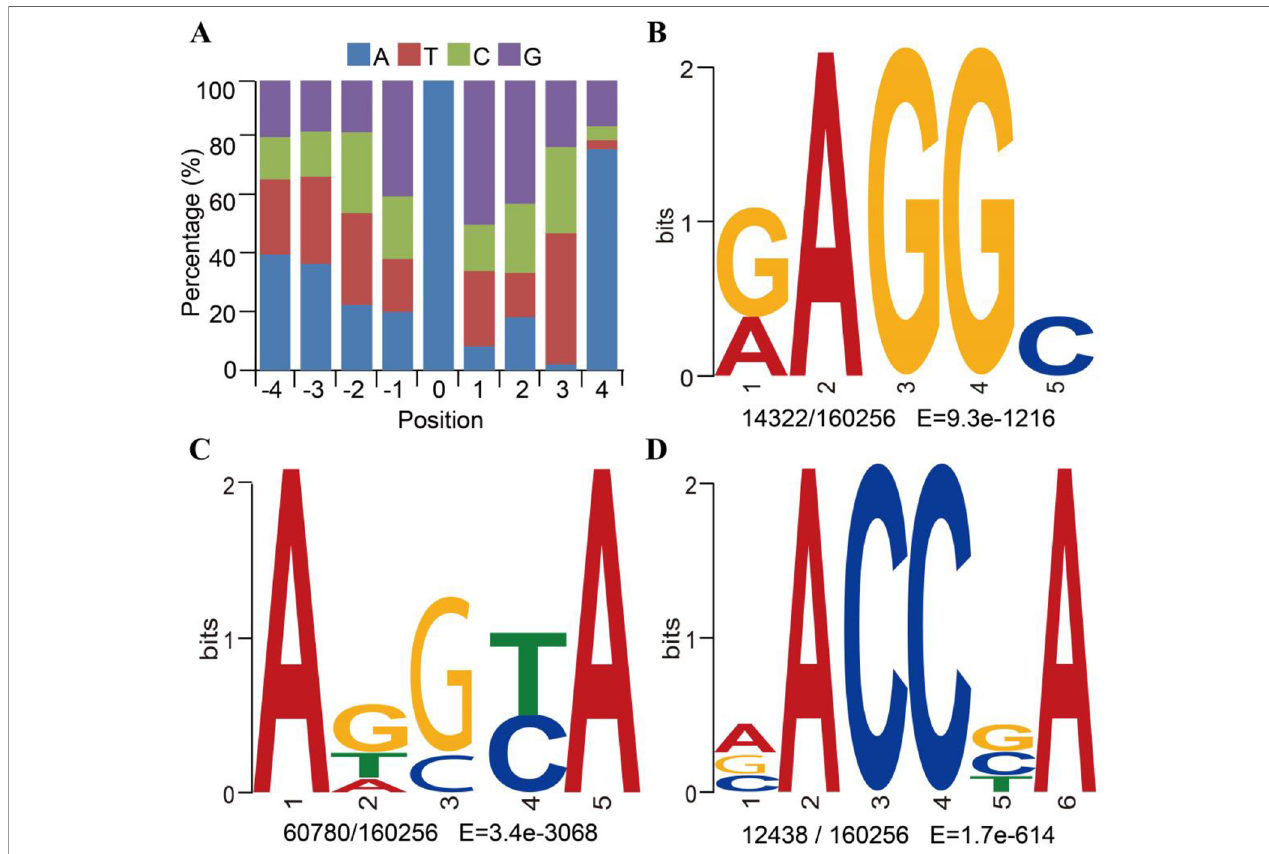
FIGURE 2 | Motif sequences of N 6 -methyladenine ( 6mA ) modi fi cation sites in Fragaria vesca v1.0 genome. (A) Content percentage of the bases A, T, C, and G in the upstream and downstream 4 bp of 6mA sites (position “ 0 ” ). (B – D) Motif sequences of 6mA detected by MEME assay: RAGGY (B) ; ADSYA (C) ; and VACCBA (D) . Sequence logo representations of the consensus motifs containing 6mA sites identi fi ed by MEME. The number of occurrences of each motif relative to the total number of 6mA-containing motifs and the corresponding E value generated by MEME are shown under the logo